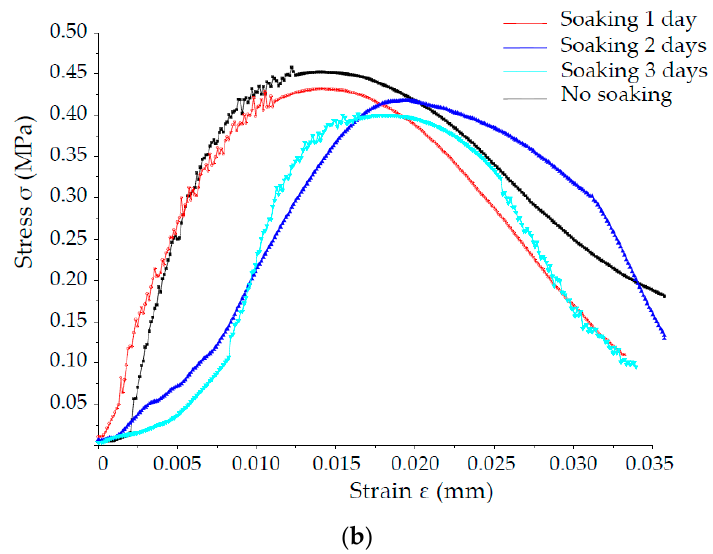
Figure 9. The stress and strain curves of similar-material: ( a ) Mudstone; ( b ) Sandstone.